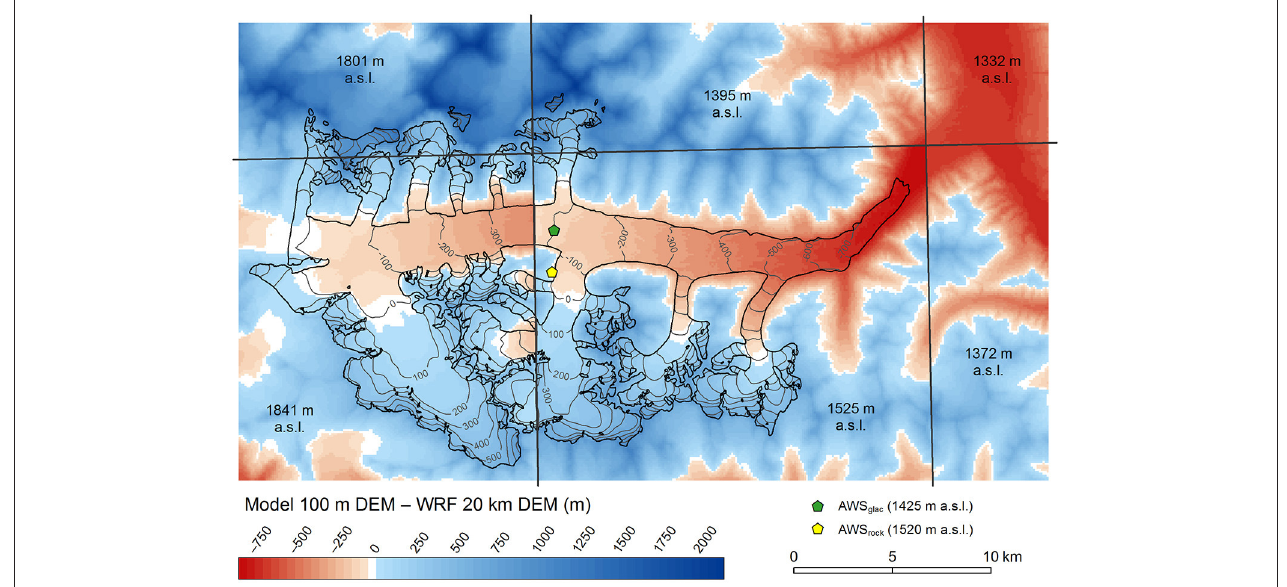
FIGURE 4 | Elevation difference between the 100 m DEM used for the glacier modeling (year 2010) and the 20 km DEM used to dynamically downscale the ERA-Interim data. Elevation differences exceed 1,000 m in the highest and − 700 m in the lowest glacier reaches. The edges of the 20 km DEM cells are indicated with black lines and the cell elevations are annotated. Within the glacier perimeter, 100 m contours of the elevation differences are given for reference. Prior to the differencing, the 20 km DEM was resampled to 100 m. AWS glac and AWS rock mark the locations of the two weather stations.